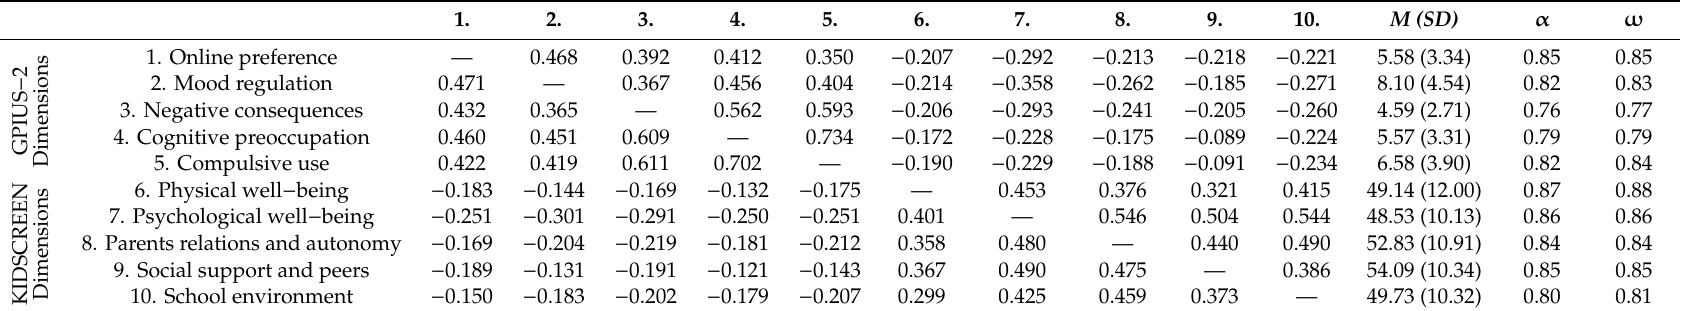
Table 5. Partial correlations (controlling for age) between the GPIUS2 dimensions and the five KIDSCREEN-27 dimensions in boys and girls. Means and standard deviations are included for the study sample ( n =